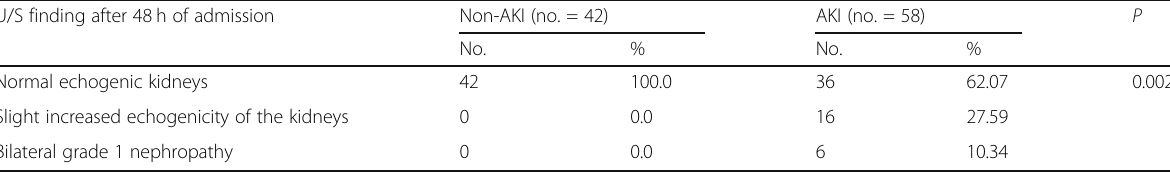
Table 6 Relation between sonographic findings and kidney injury among the studied groups U/S finding after 48 h of admission Non-AKI (no. = 42) AKI (no. = 58) No. % No. % Normal echogenic kidneys 42 Slight increased echogenicity of the kidneys 0